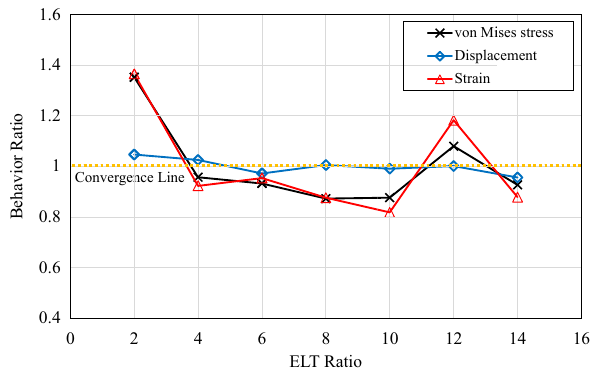
Figure 4: Summary of the convergence assessment of the plate with one longitudinal sti ff ener.